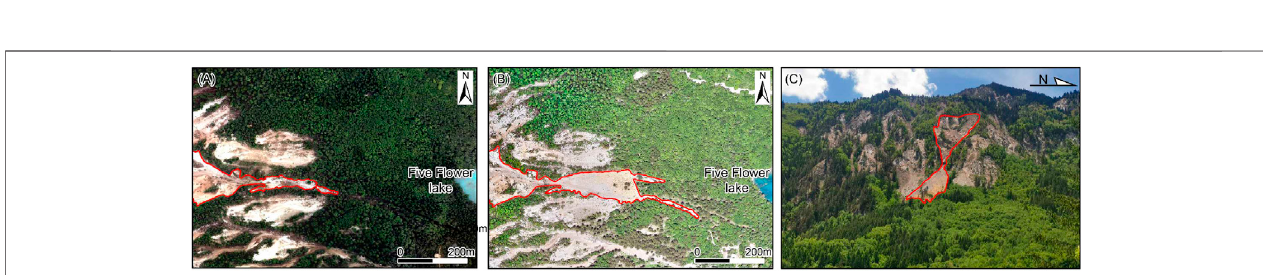
FIGURE 7 | Inventory map of the restored landslide area (A) Restored landslide map (B) Restored landslide map of Jiuzhaitiantang (C) Restored landslide map of Panda Lake.